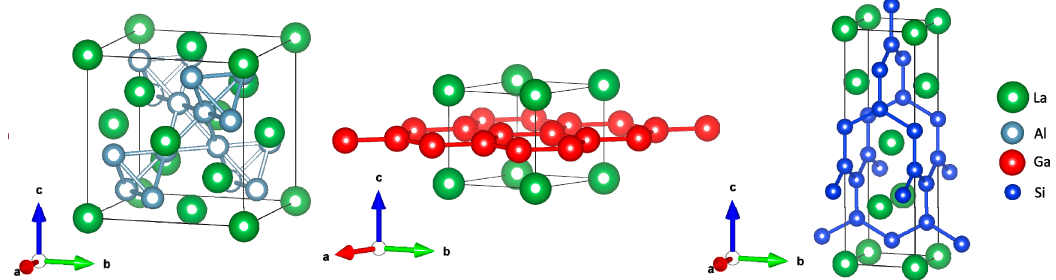
Figure 1. Crystal structures of LaAl 2 (MgCu 2 type, left ), LaGa 2 (AlB 2 type, middle ), and LaSi 2 (ThSi 2 type, right ). The polyanionic networks are emphasized.